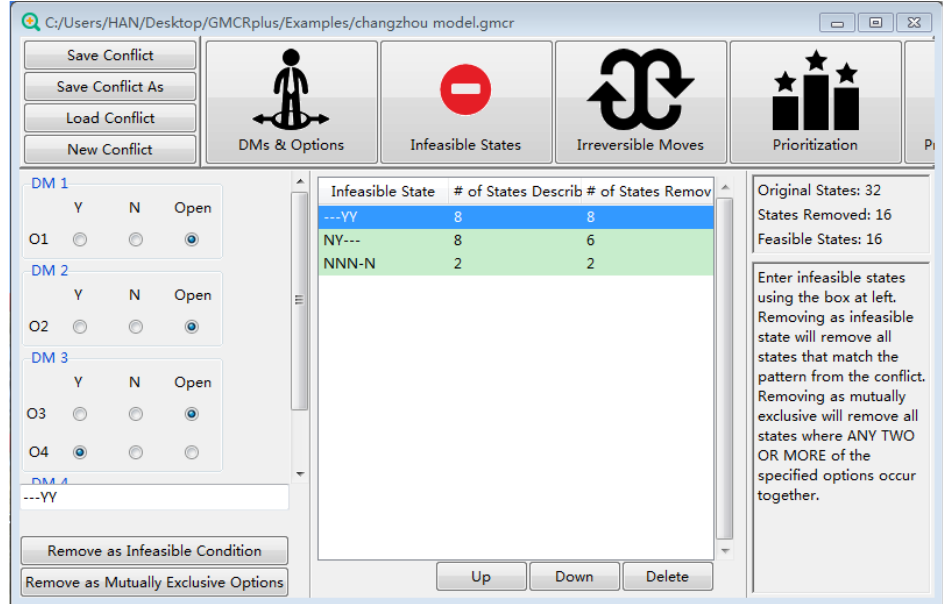
Figure 8. The process of removing infeasible states. Table 4. Feasible states.